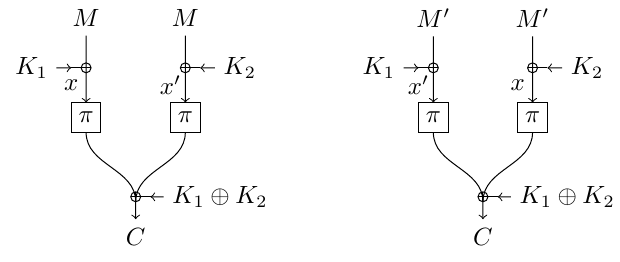
Figure 1: SoEM1 - Swapping x and x 0 .